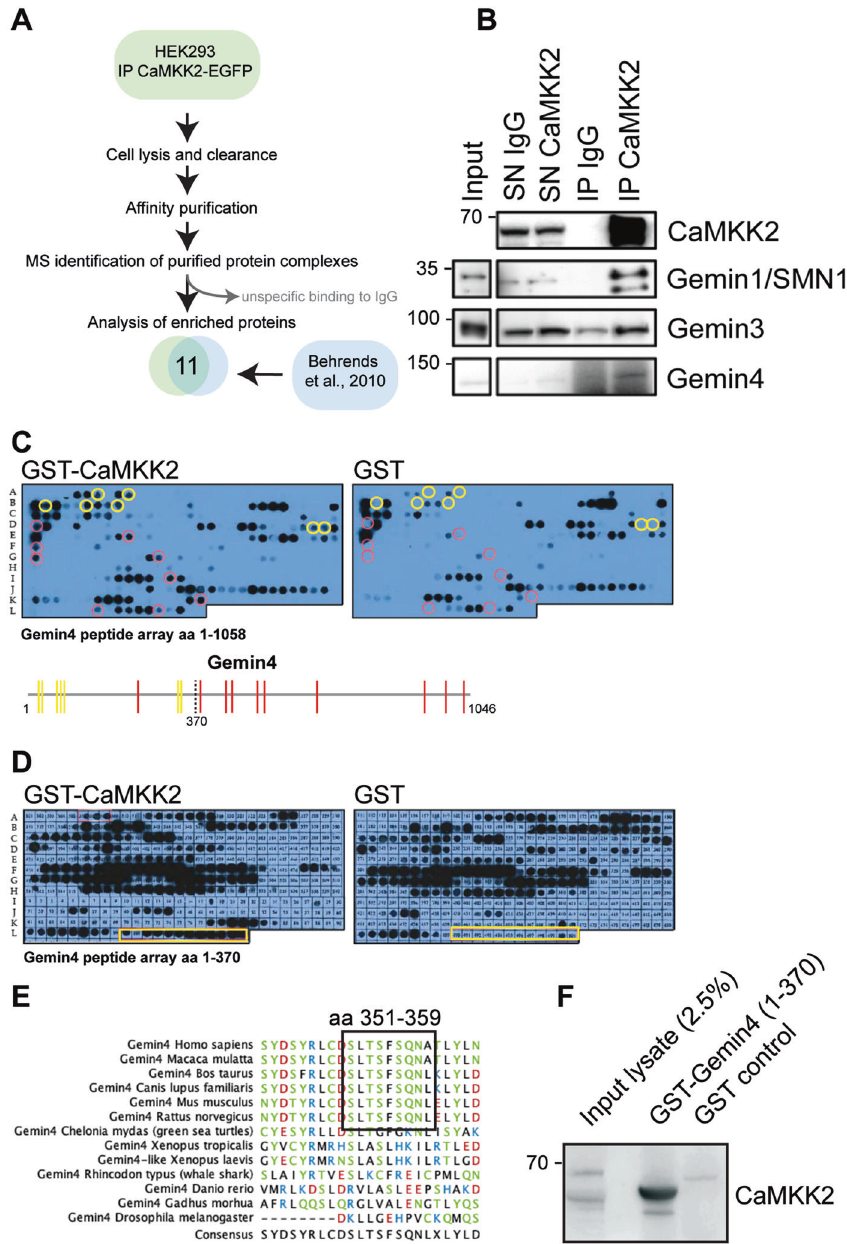
Fig. 1 Identi fi cation of novel CaMKK2 interaction partners. A Schematic outlining the proteomics experimental design and work fl ow to identify CaMKK2-interacting proteins by co-immunoprecipitation (co-IP). HEK293 cells were transfected with EGFP-tagged CaMKK2, co- immunoprecipitated proteins were identi fi ed by mass spectrometry and the data were compared with a previously published data set [6]. B Immunoprecipitation of endogenous CaMKK2 from LNCaP cells showed co-immunoprecipitation of the Gemin complex. Immunoprecipitates (IP) with a control IgG were compared with those of CaMKK2 IgG, input lysate and unbound supernatant (SN). Bound proteins were evaluated by western blotting with the indicated antibodies. C A peptide array of full-length Gemin4 divided into 20 amino acid peptides with a 17 amino acid overlap was spotted on two nitrocellulose membranes. The membranes were incubated with either GST-CaMKK2 or GST alone. Bound GST protein was detected with a HRP-conjugated GST antibody. Yellow circles indicate peptides that bound CaMKK2 and had overlapping sequence with neighbouring peptides and red circles denote peptides that bound CaMKK2 but did not contain sequence overlap. A schematic drawing illustrates the sequence location of the highlighted peptides, which were concentrated in the fi rst 370 aa of the Gemin4 sequence. D A peptide array of the N-terminal region of Gemin4 (aa 1 – 370) using 20 aa peptides with a 19 aa overlap. The peptide array was incubated with GST-CaMKK2 and GST control. The yellow box highlights the region in Gemin4 where GST-CaMKK2 but not GST bound. E Multiple sequence alignment of the CaMKK2-binding motif (CBM; aa 351 – 359) in Gemin4 identi fi ed in the peptide array illustrates sequence conservation across species. F To verify the speci fi city of the interaction in solution recombinant GST-tagged Gemin4 (aa 1 – 370) was used in a pulldown assay with LNCaP cell extracts. Equal amounts of control GST and GST-Gemin4 were used in the assay. The CaMKK2 binding was detected by western blotting.